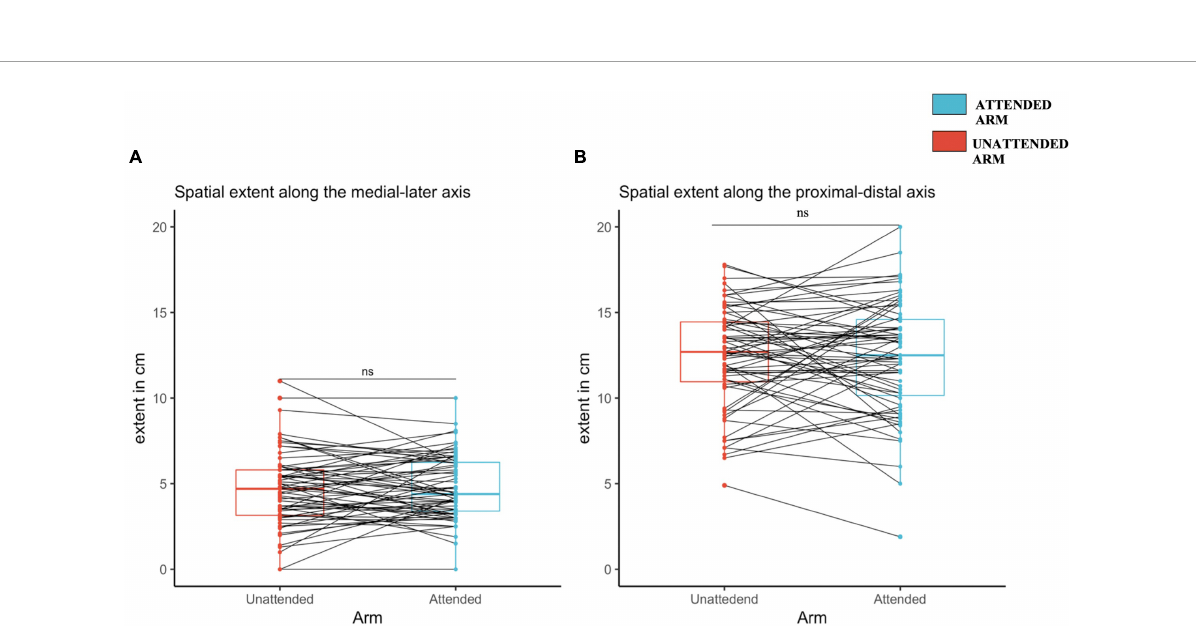
FIGURE4 Spatial extent of increased pinprick sensitivity induced by high frequency stimulation (HFS), assessed using a probe with an exerting force of 128 mN at the attended and the unattended arm, 20 min after HFS. (A) Medial-later axis. (B) Proximal-distal axis. The red (unattended arm) and the blue (attended arm) bold lines in the boxplots represents the median of the extent of the area of increased mechanical sensitivity. A one-sided paired sample t -test was used to compare the spatial extent in mechanical sensitivity along the medial-lateral axis (A) and the proximal-distal axis (B) . Each dot represents a single participants extent of the area of increased sensitivity along the two different axes, (A) for medial-lateral, and (B) for proximal-distal. The continuous line indicated with “ns” means that there was no significant difference between the two conditions, attended and